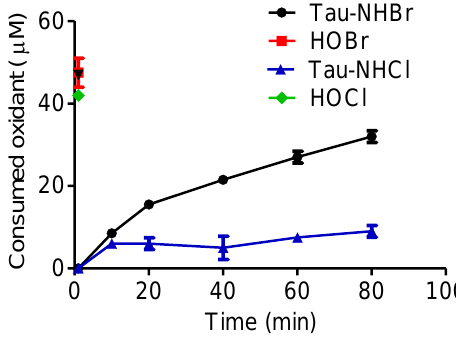
Figure 11. Reactivity with linoleic acid. The reaction mixtures were composed of 50 µM Tau-NHBr, Tau-NHCl, HOBr, or HOCl and 100 µM linoleic acid in 50 mM phosphate buffer, pH 7.0. After the indicated time, the remaining oxidants were measured by the TNB method. The results are the mean of three experiments. HOCl and HOBr were totally consumed in the first minute of reaction.